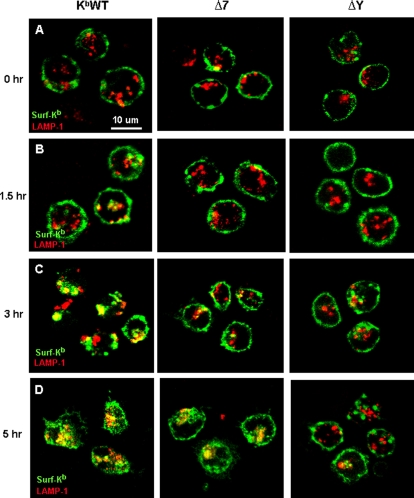
MHC-I cell surface-to-lysosome trafficking in DCs is impaired by mutation in the cytoplasmic tyrosine residue.(A to D) Splenic DCs isolated from KbWT, and Δ7 and ΔY transgenic mice were mounted on coverslips, labeled with FITC-conjugated H-2Kb-specific mAb, washed, and incubated at 37°C for the indicated times. DCs were then fixed, permeabilized, and counterstained for LAMP-1. Yellow color indicates co-localization of surface-derived H-2Kb (green) with LAMP-1 (red). Data are representative of at least 3 images captured from 2 independent experiments.